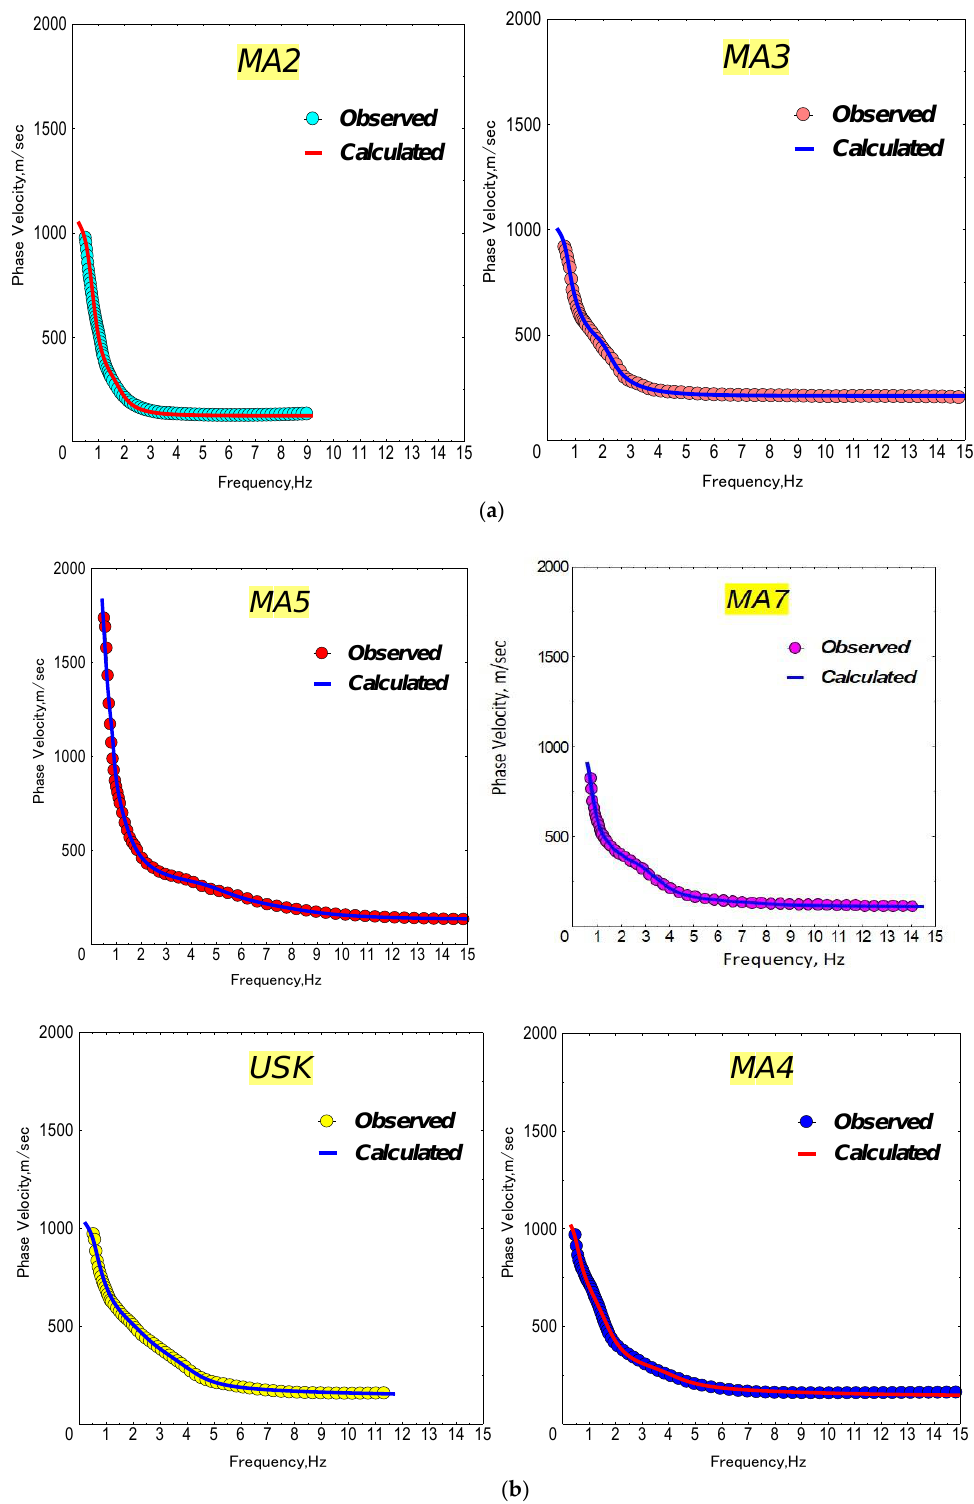
Figure A1. The inversion process of dispersion curves fitting both of the Vs structure profiles ( a ) NW–SE (AA’) direction and ( b ) SW–NE (BB’) orientation.